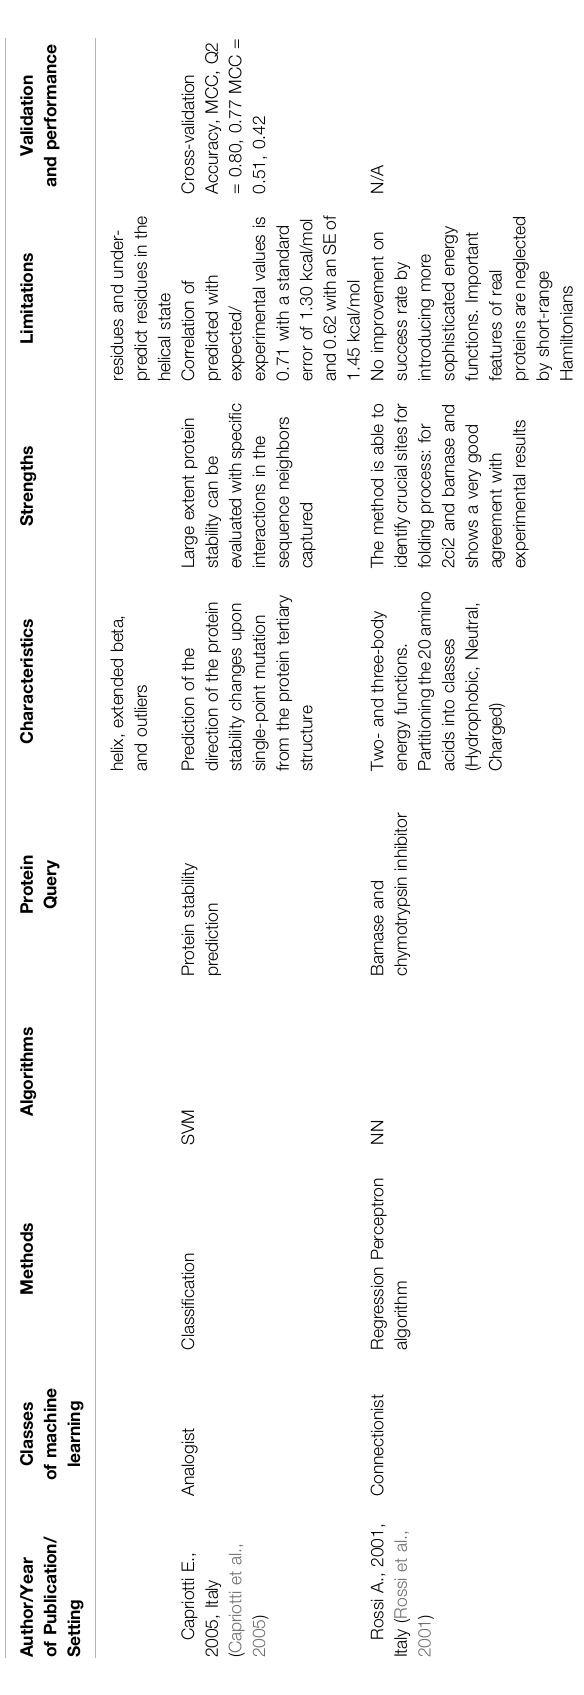
Table 1 : Pre-process, process, and post-process, each of which contain, in turn, the following items: pre-process database, pretreatment, and input process